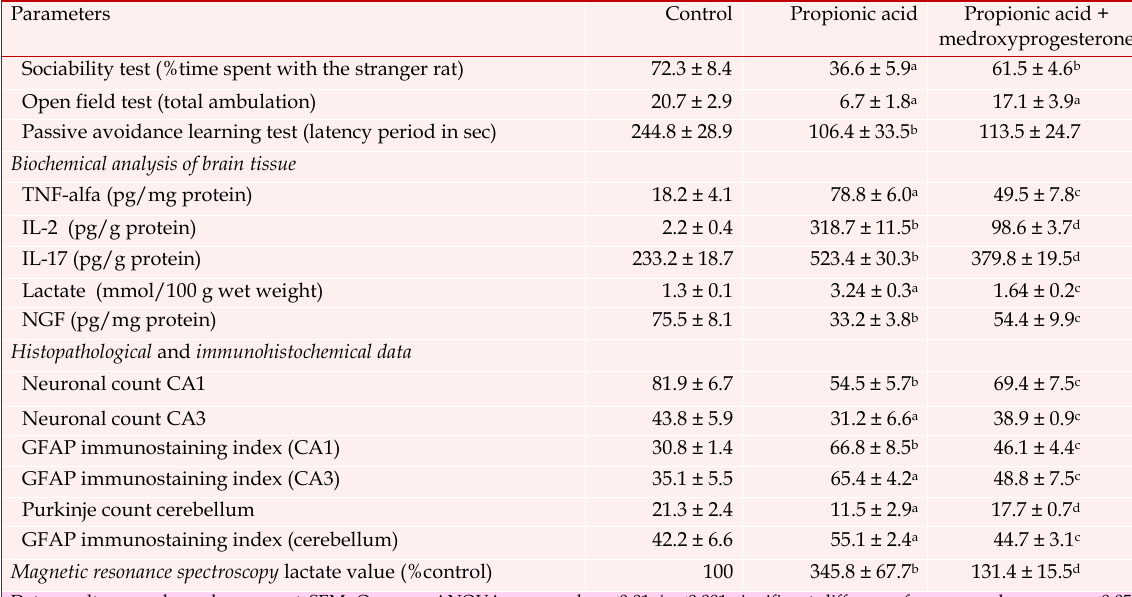
Effects of medroxyproprogesterone on different parameters in rat